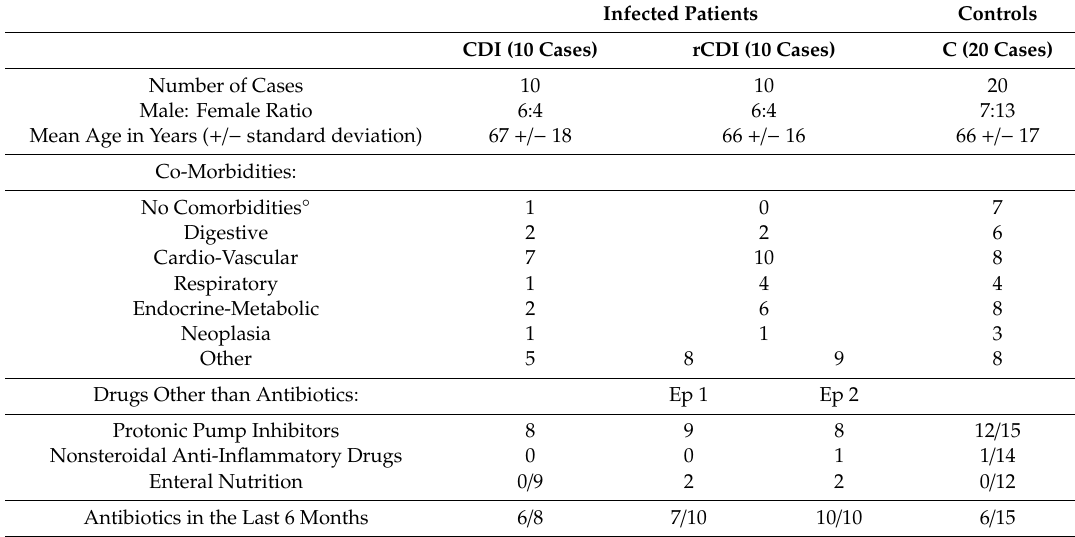
Table 1. Demographic and clinical features of study cohorts. Abbreviations: CDI = patients su ff ering from non-recurrent C. di ffi cile infection; rCDI = patients su ff ering from recurrent C. di ffi cile infection; C = non-infected